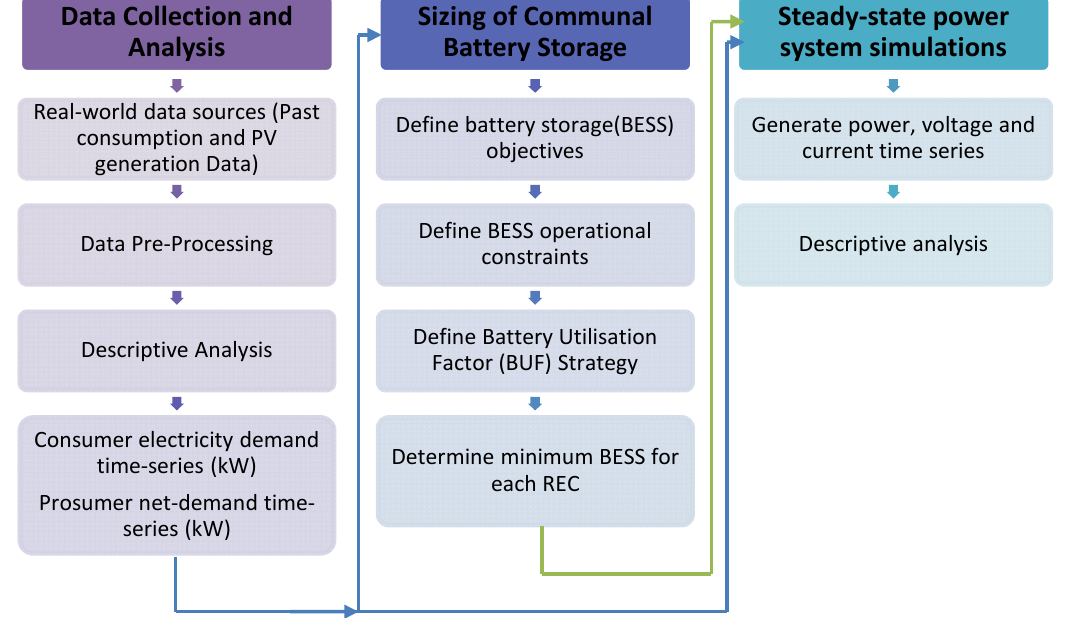
Figure 3. Methodology applied in this study to analyze the potential of RECs in reducing the reverse power flows and reducing the evening peak demand.